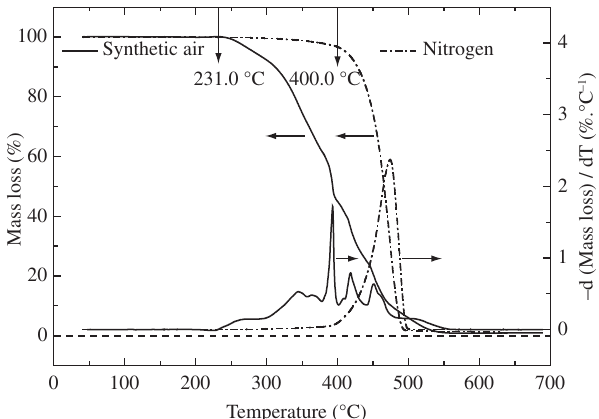
Figure 1. Typical polyolefin thermogravimetric curves in synthetic air and in nitrogen from ambient temperature to 700